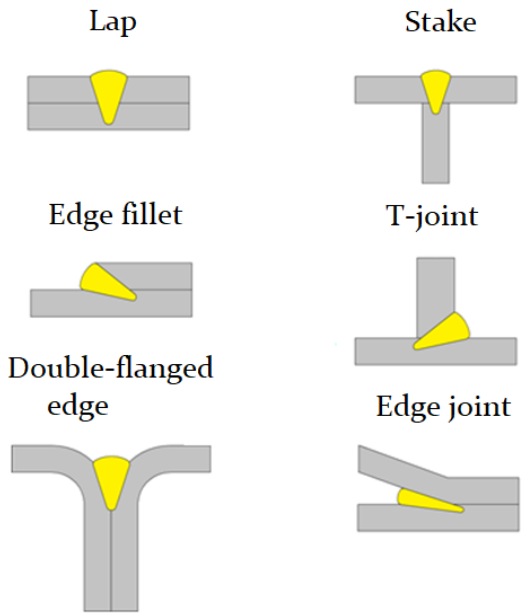
Figure 3. Joint configurations. Author own figure.